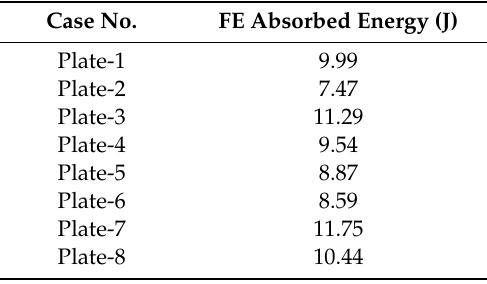
Table 12. Summary of the predicted absorbed energy for the new proposed designs. Case